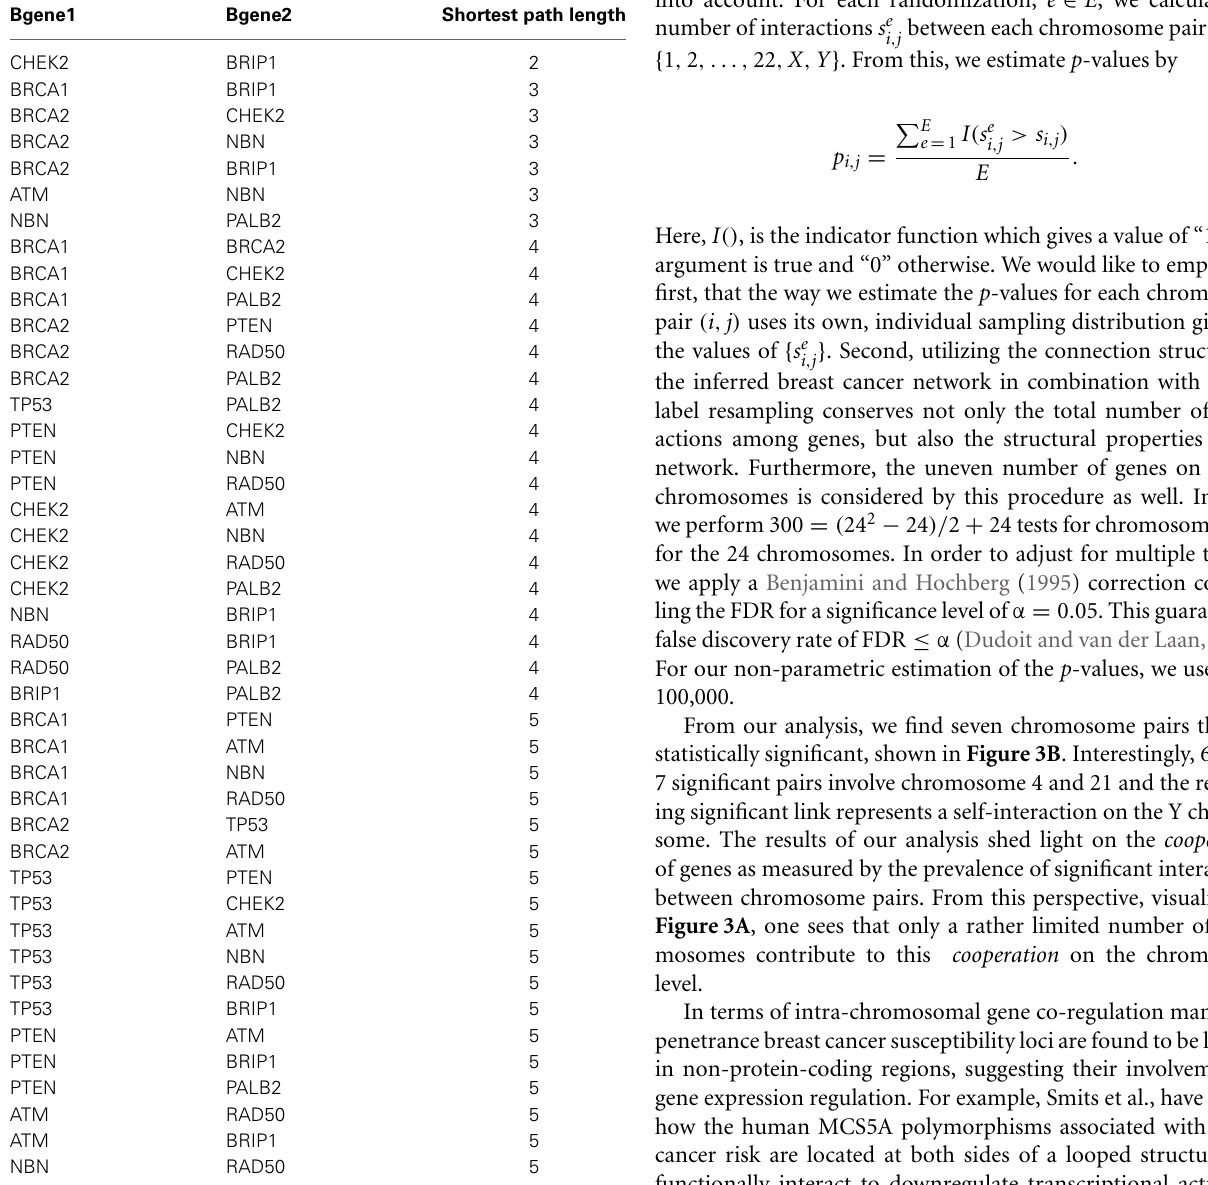
Table 3 | Length of the shortest path between pairs of breast cancer genes (Bgene1 and Bgene2). Bgene1